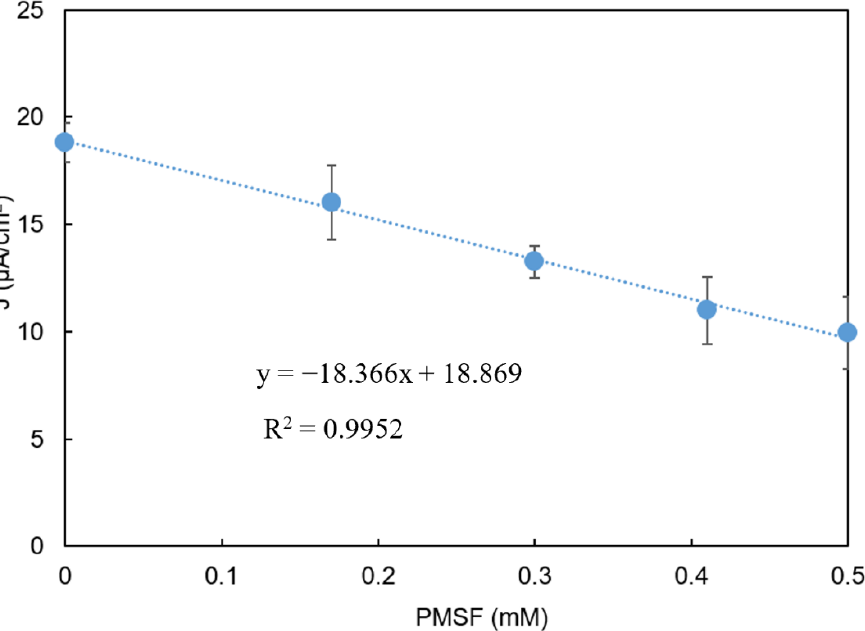
Figure 7. Control experiment to study the effect of phosphate buffer addition on the bi-enzyme bi- osensor’s signal.